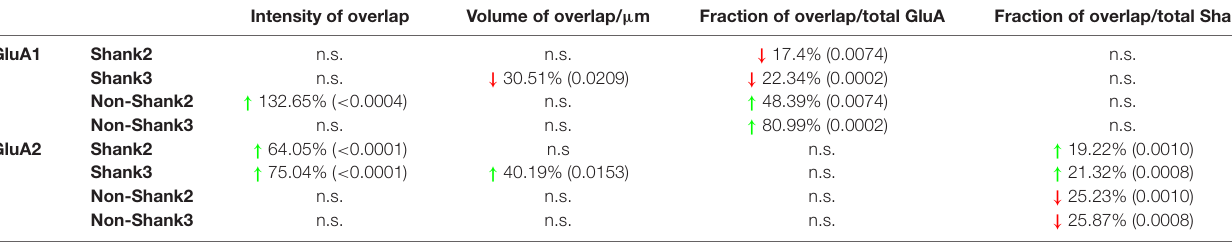
TABLE 1 | Effect of zinc on GluA—Shank colocalization. Intensity of overlap Volume of overlap/ µ m Fraction of overlap/total